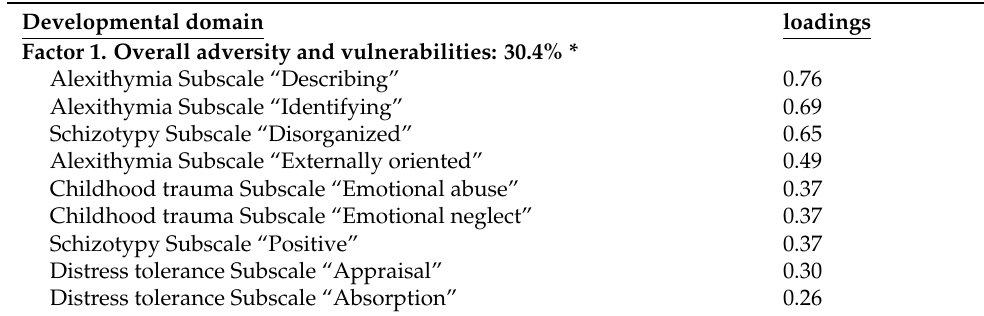
Table 2. Computed factors and loadings. Developmental